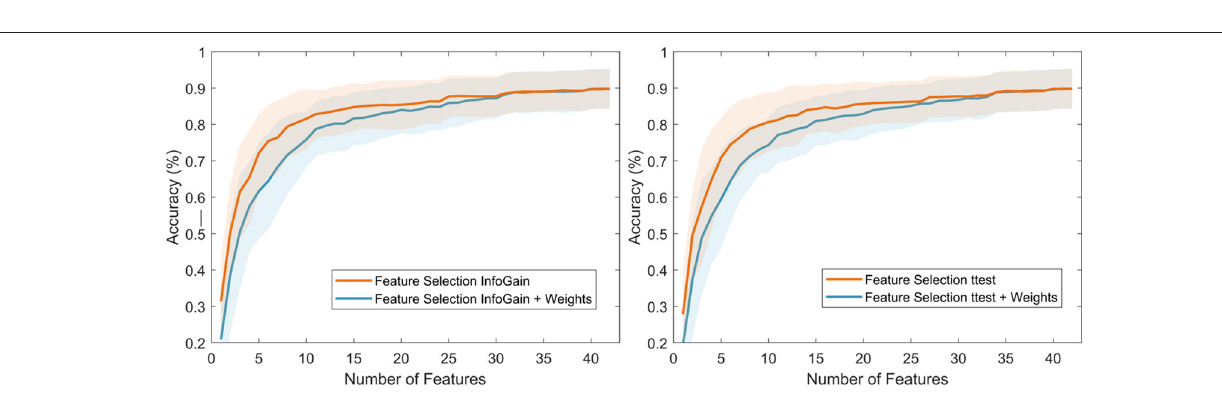
FIGURE 9 | Cortical locations of the top 19 features in the three bands explored in this study.